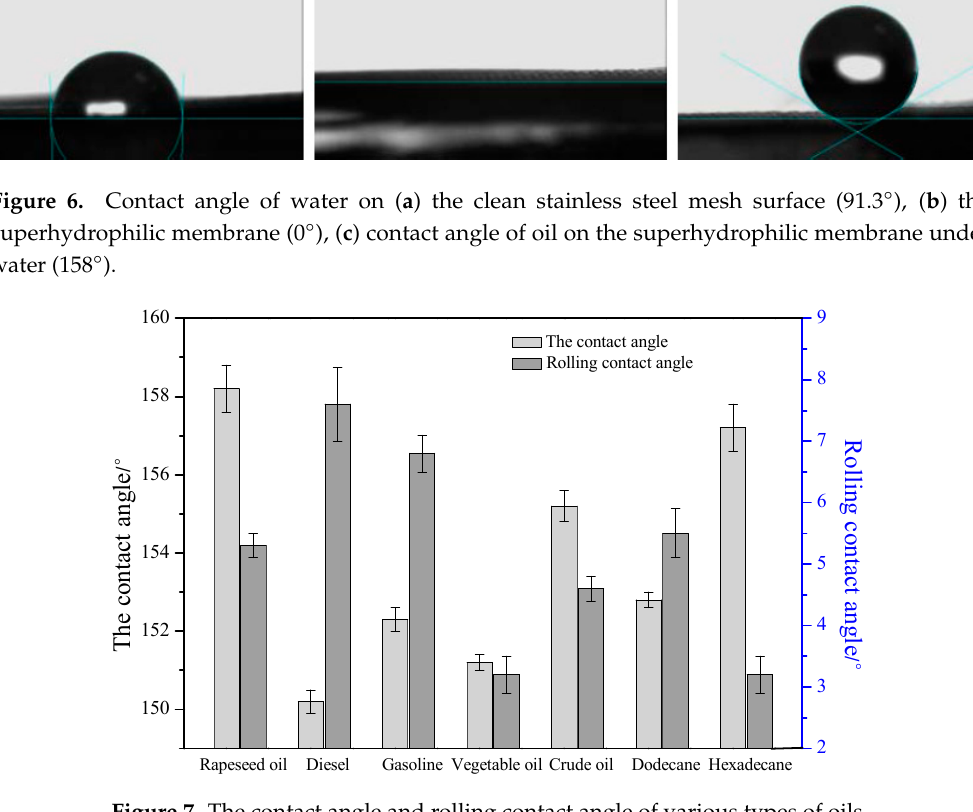
Figure 7. The contact angle and rolling contact angle of various types of oils.